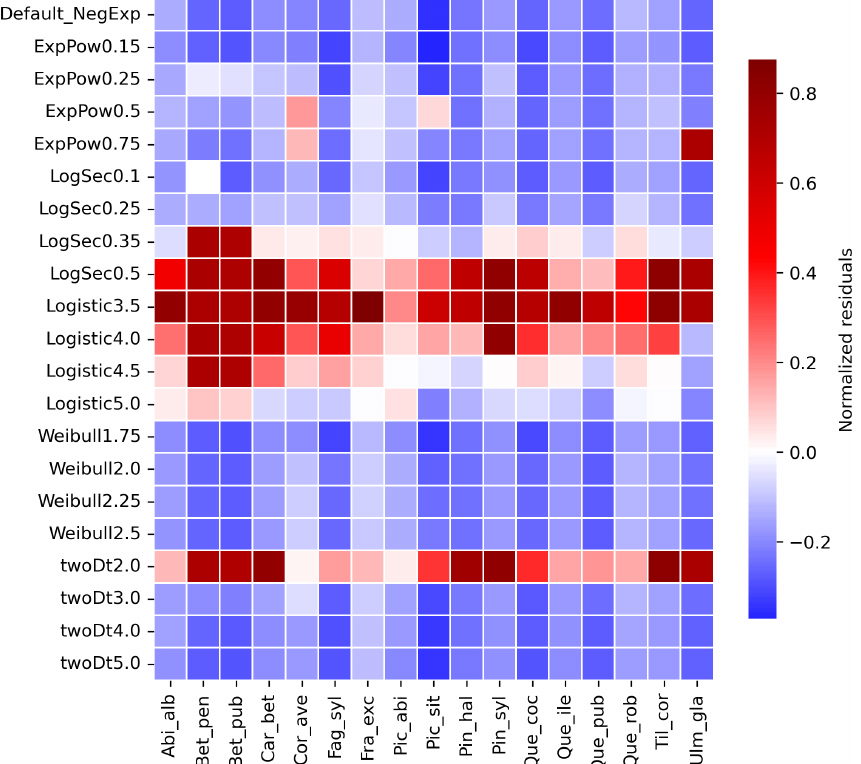
Figure 4. Species-specific performance of seed kernels for different shape parameters. The heat map shows the species-specific normalized residuals between simulated migration rates and observed maximum historical estimates for the default negative exponential function (“De- fault_NegExp”) and the newly implemented fat-tailed kernels across examples of shape parameter values (“ { kernel name } +{ b value } ”; cf. Fig. 3). Red and blue indicate over- and under-estimations, respectively. See Table S3 for species- and kernel-specific residuals and simulation values for all tested shape parameter values.